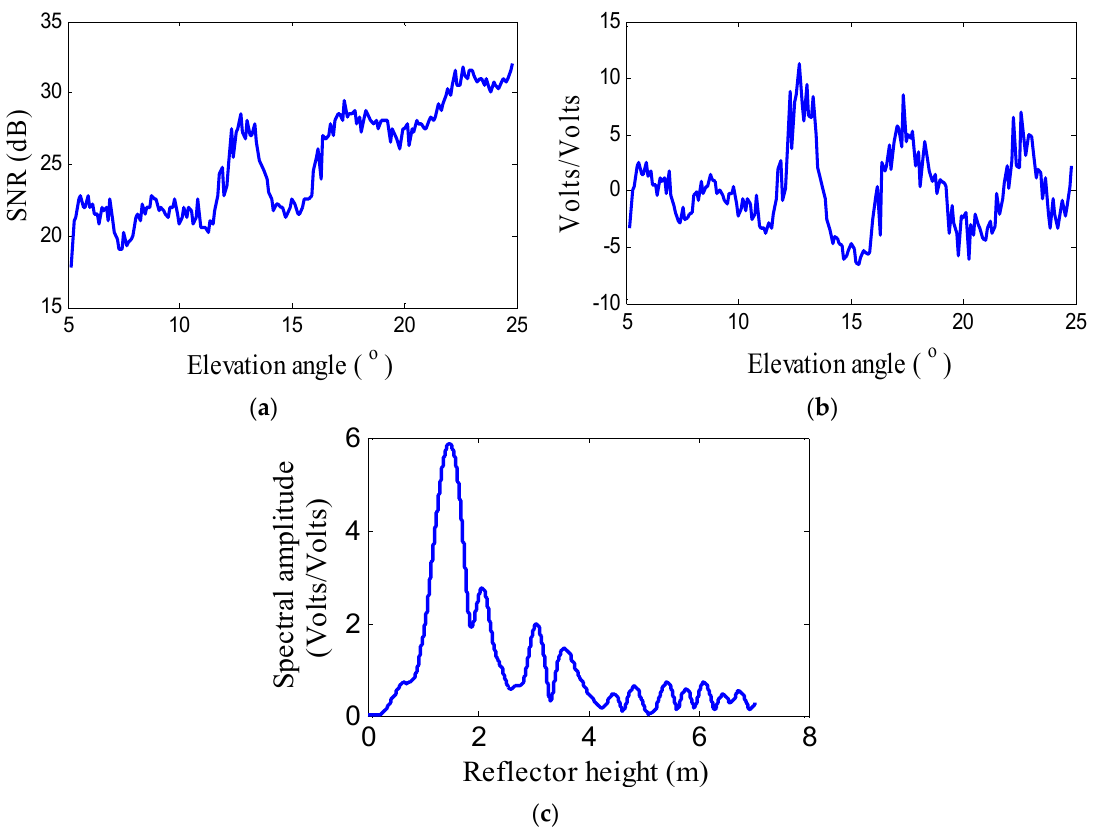
Figure 3. L2P SNR data, multipath modulations and Lomb–Scargle periodogram of multipath pattern at AB33. ( a ) L2P SNR data from satellite PRN10; ( b ) Multipath modulations; ( c ) Lomb-Scargle periodogram of multipath pattern.